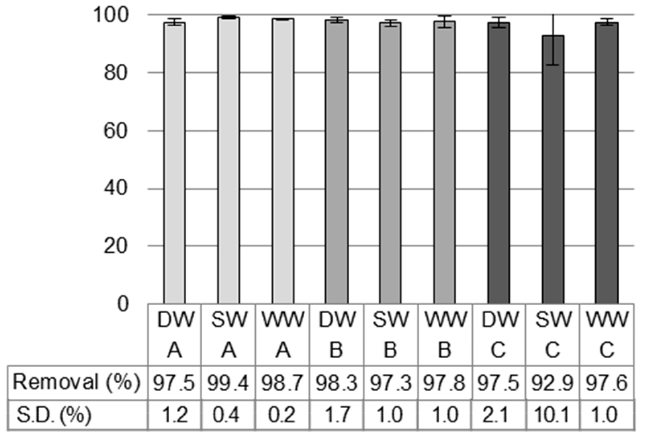
Figure 3. Removal efficiency for 100 mg mixture of PE/PP (1:1) from 1 L demineralized water (DW), salt water (SW) or biologically treated wastewater (WW) using 100 μ L organosilane (A = PE ‐ X; B = n ‐ Butyltrichlorosilane; C = Isooctyltrichlorosilane).